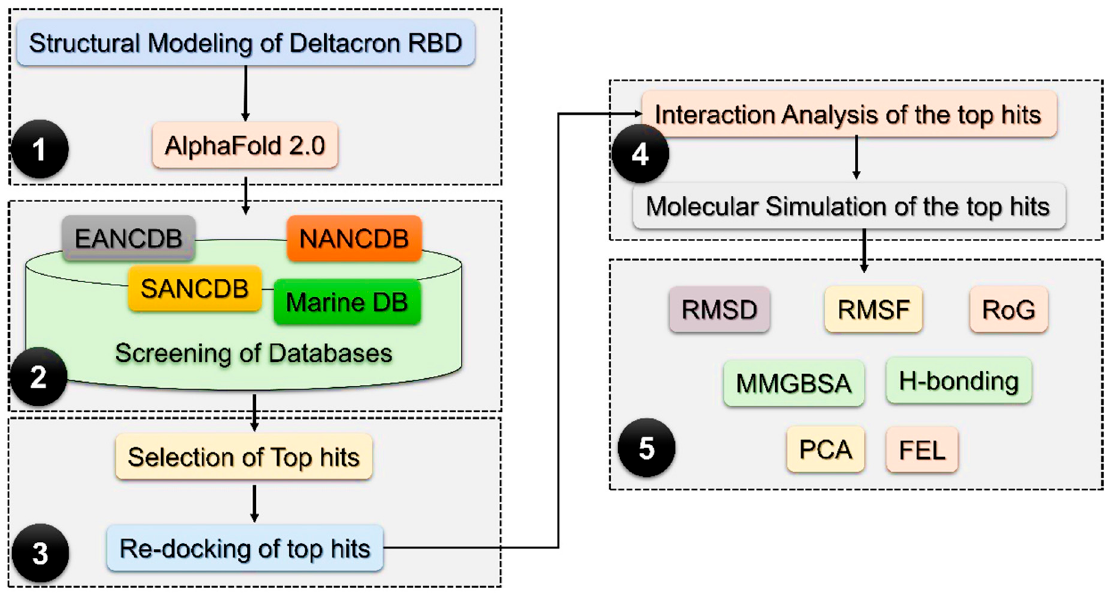
Figure 1. Methodological flow of the whole study. The first step is the modelling of the structure using AlphaFold. In the second step, database retrieval, preparation, and screening are involved. In the third step, the re-evaluation of the top hits from each database is performed, while in the fourth and fifth steps, the validation of the top hits using molecular simulation is performed.